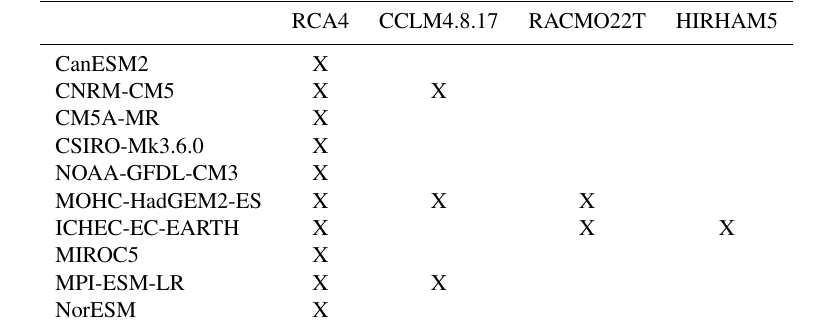
Table 1. GCMs and RCMs, where X indicates a RCM–GCM combination used in this study. The RCM description papers are as follows: RCA4 (Chylek et al., 2011), RACMO22T (van Meijgaard et al., 2008), HIRHAM5 (Christensen et al., 2006). The GCM description papers are as follows: CNRM-CM5 (Voldoire et al., 2013), CM5A-MR (Dufresne et al., 2013), CSIRO-Mk3.6.0 (Rotstayn et al., 2012), NOAA- GFDL-CM3 (Griffies et al., 2011), MOHC-HadGEM2-ES (Jones et al., 2011), ICHEC-EC-EARTH (Hazeleger et al., 2012), MIROC5 (Watanabe et al., 2010), MPI-ESM-LR (Raddatz et al., 2007), NorESM (Bentsen et al., 2013).